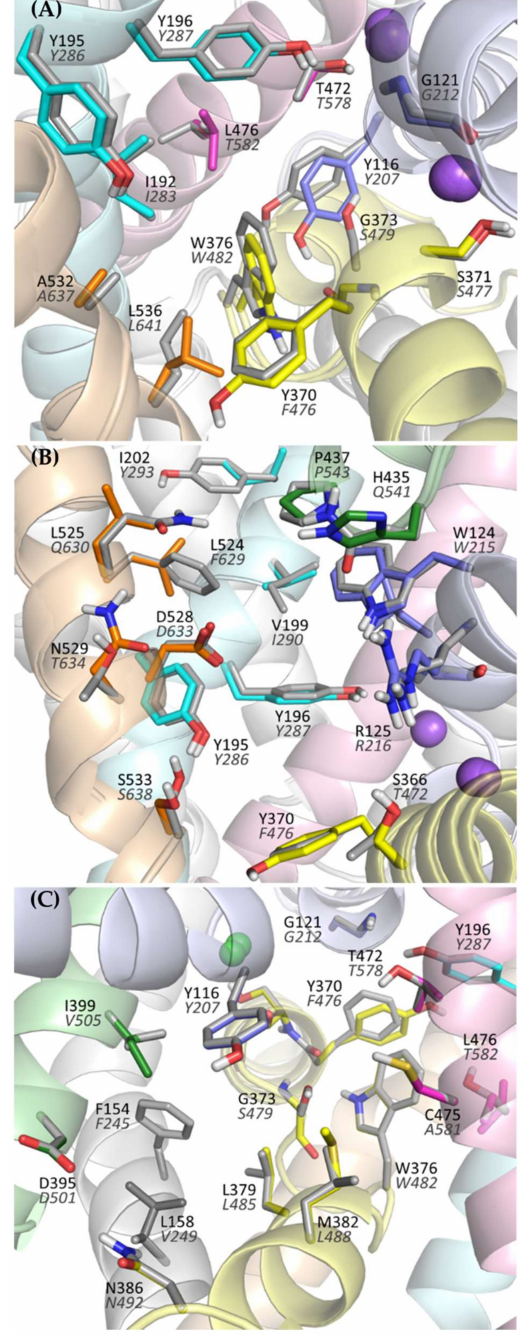
Figure 4. Amino acids forming the main binding site (S1) ( A ), vestibule ( B ), and intracellular release pathway ( C ) of the glycine transporters. For GlyT-1, residues are presented in color (according to transmembrane domains), whereas for GlyT-2 gray is used for clarity. Labels for GlyT-2 are shown in gray